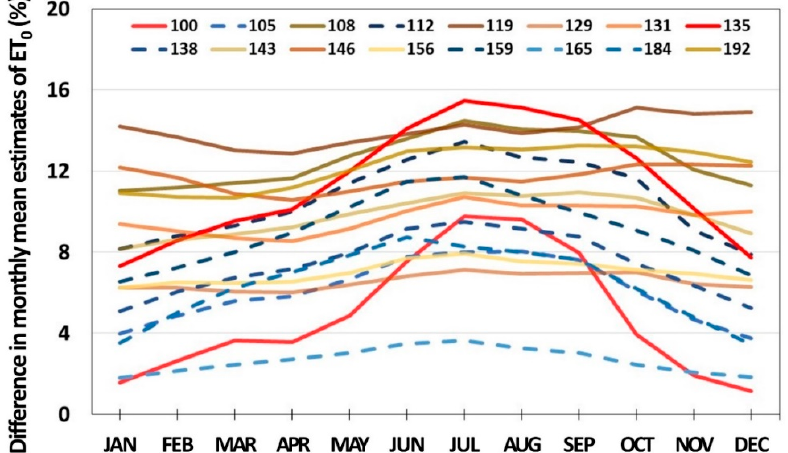
Figure 2. The difference in monthly mean estimates of reference crop evapotranspiration (ET 0 ). The series of solid brown lines indicate the inland study sites, and the series of blue dotted lines represent the study sites on the coast. The series of solid red lines are the study sites in the mountainous regions.